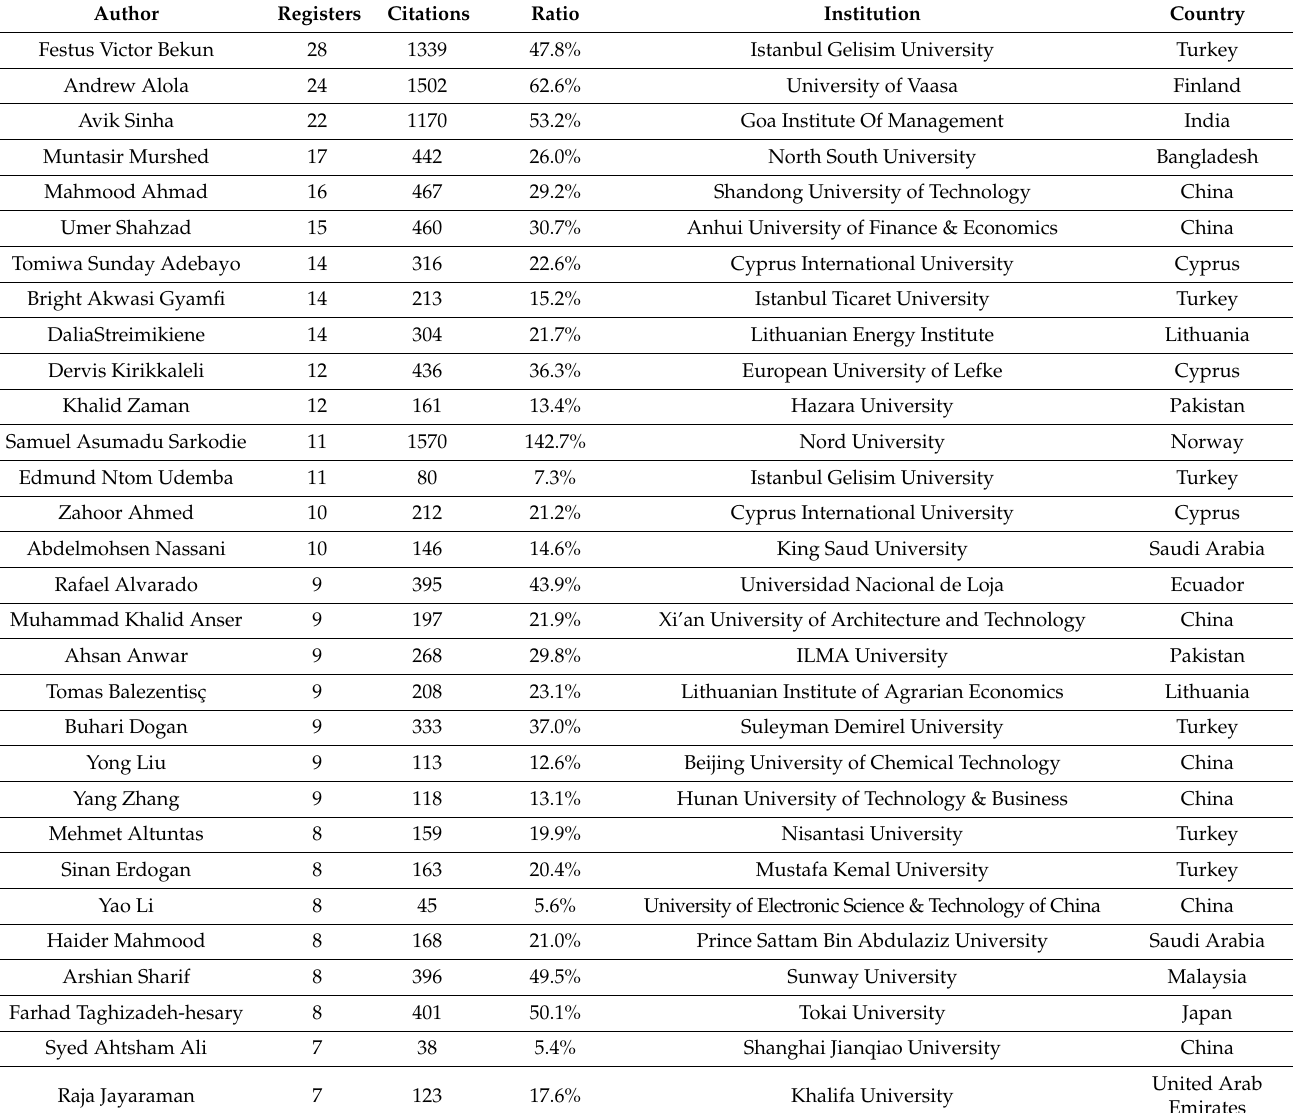
Table 3. Number of records, citations, work impact, and affiliation country for each main author